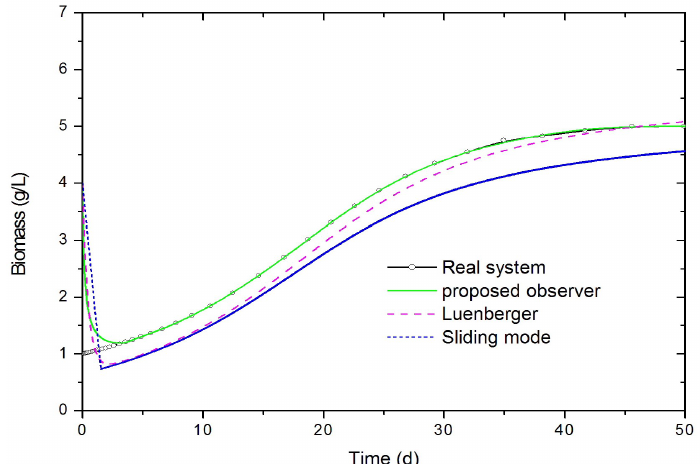
Figure 3. Simulation and comparison of the continuous-time observers, proposed observer vs. real system: Dynamics of the substrate.